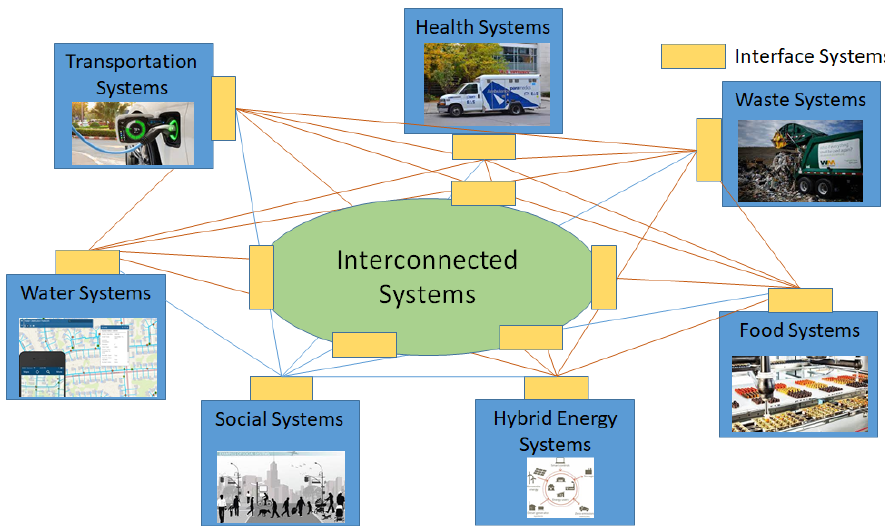
Figure 1. HES within interconnected infrastructures.